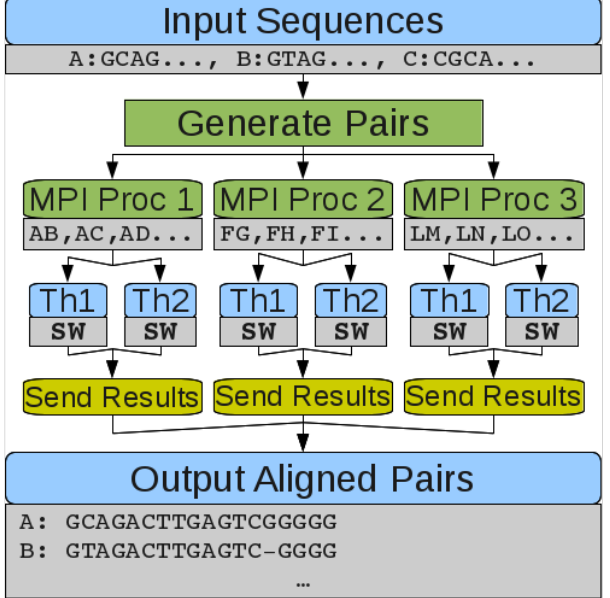
Figure 3: Parallel multiple pairwise alignment